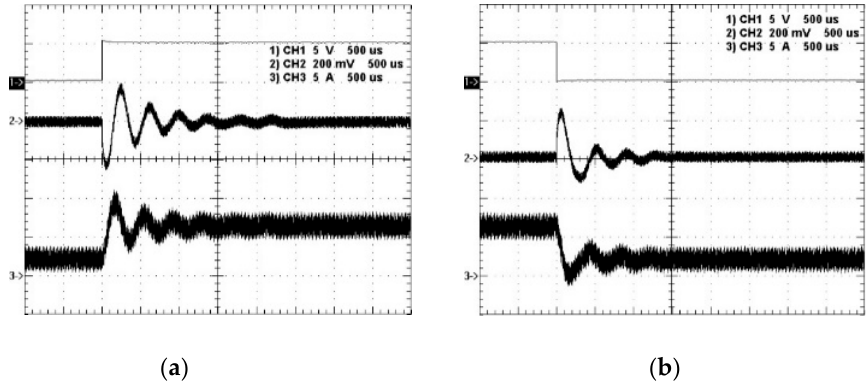
Figure 14. Waveforms based on the proposed PWFM control strategy: (1) load enable; (2) AC output